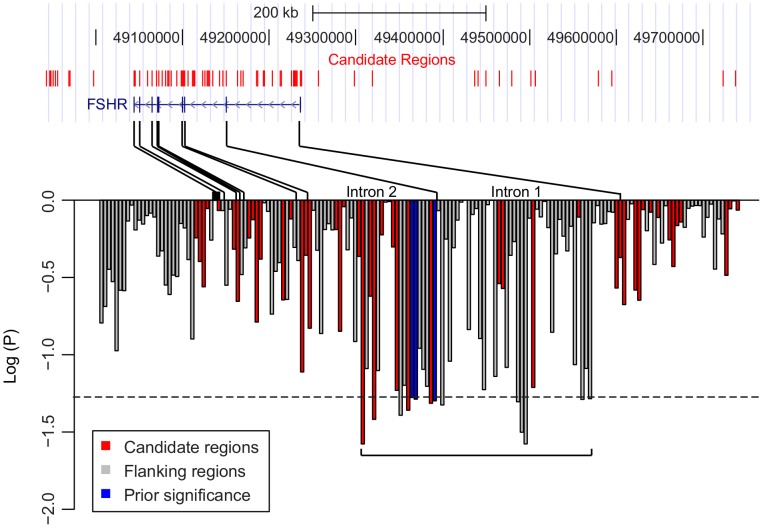
Fine-map of the association between common variants and preterm birth.Each of 169 variants with minor allele frequency greater than 5% was tested for the allelic association with pre-term birth using a two-proportion Z-test. The log10 of the P-value is shown for each SNP ordered by is position at the FSHR locus, shown above, with lines indicating intron boundaries and red ticks indicating the positions of 67 candidate regions sequenced. Bars are red for SNPs within candidate regions, gray for SNPs in flanking regions, and blue for those found significant in [16]. The dashed horizontal line indicates the least significant P-value of the three tag SNPs in blue.